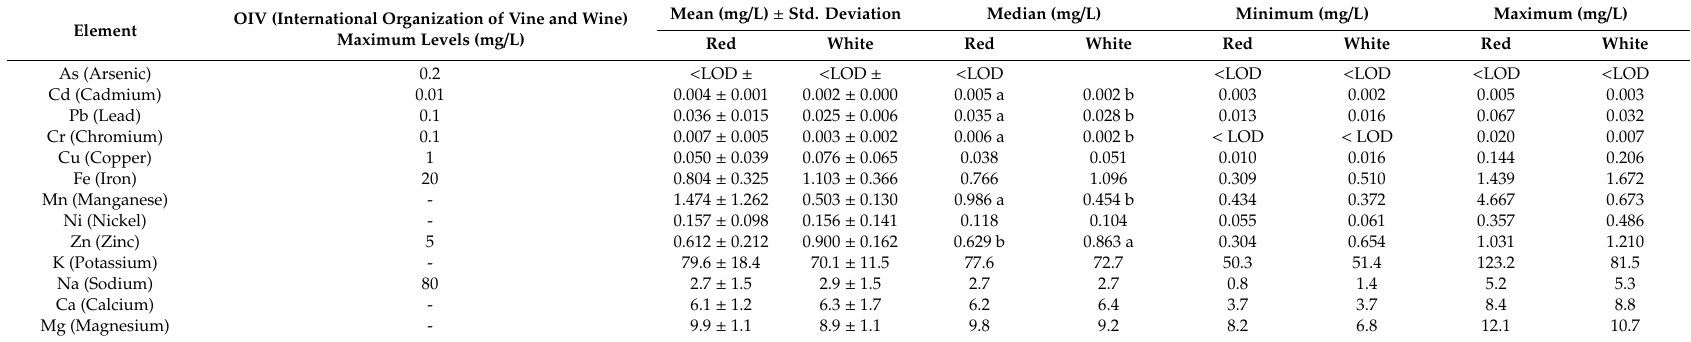
< LOD (Limit of Detection): Values lower that the limit of detection. * Within one line, medians of red and white wines with di ff erent letters di ff er significantly from each other ( p < 0.05), as determined by the Independent-Samples Median